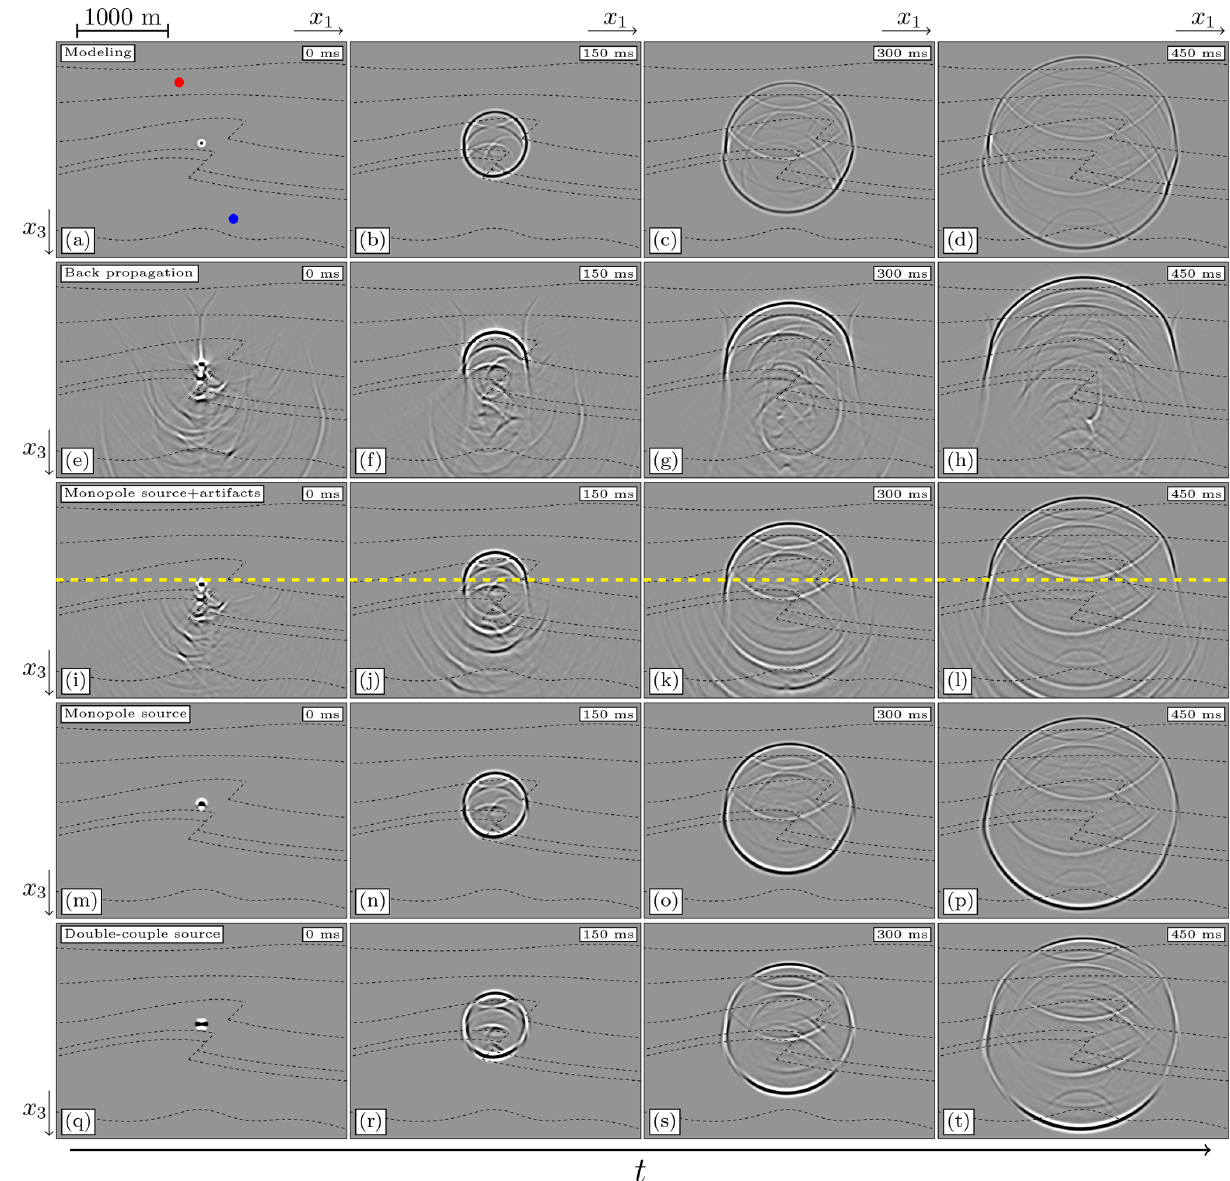
Figure 6. Snapshots of the wave field inside the white box in Fig. 5 for point sources. (a–d) Directly modeled wave field using the exact model from Fig. 5a and b. (e–h) Back-propagated wave field obtained using Eq. (23). (i–l) Wave field in the subsurface, retrieved for virtual receivers and a virtual source using Eq. (15). The yellow line indicates the border between the area below and above the virtual source. (m–p) Similar to (i–l) for the homogeneous wave field using Eq. (16). (q–t) Similar to (m–p) using Eq. (19) and a double-couple signature inclined at an angle of 45 ◦ . All wave fields have been convolved with a 30Hz Ricker wavelet. The red and blue dot indicate the locations of the traces in Fig. 7. The black dashed lines indicate the locations of geological layer